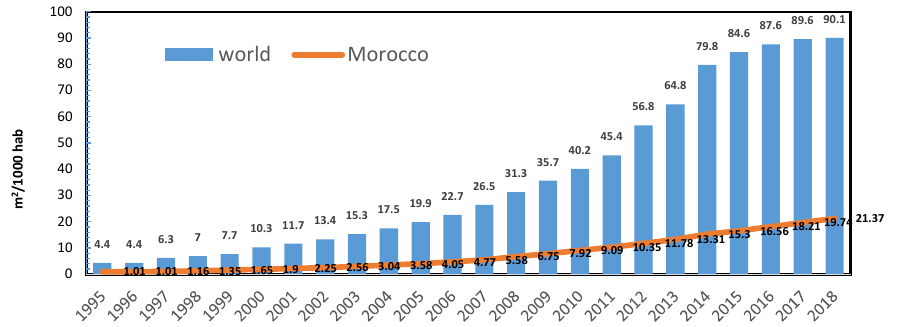
Figure 1. Evolution of the total installed area per inhabitant in Morocco compared to the world.